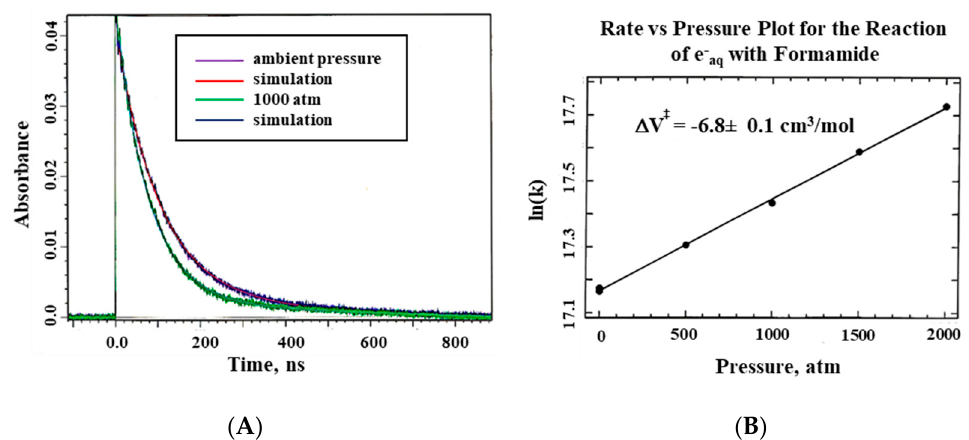
Figure 6. ( A ) Typical kinetic traces to show the acceleration of the reaction at 100 MPa induced by the LEAF facility at BNL, New York. ( B ) Plot of ln k versus pressure, where Δ V ‡ was calculated from the slope of the linear dependence on pressure.